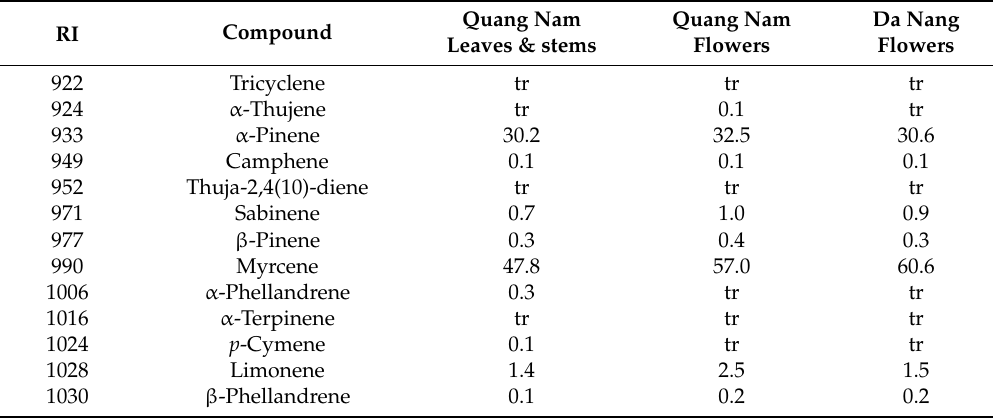
Table 2. Chemical compositions of Erechtites valerianifolius essential oils from